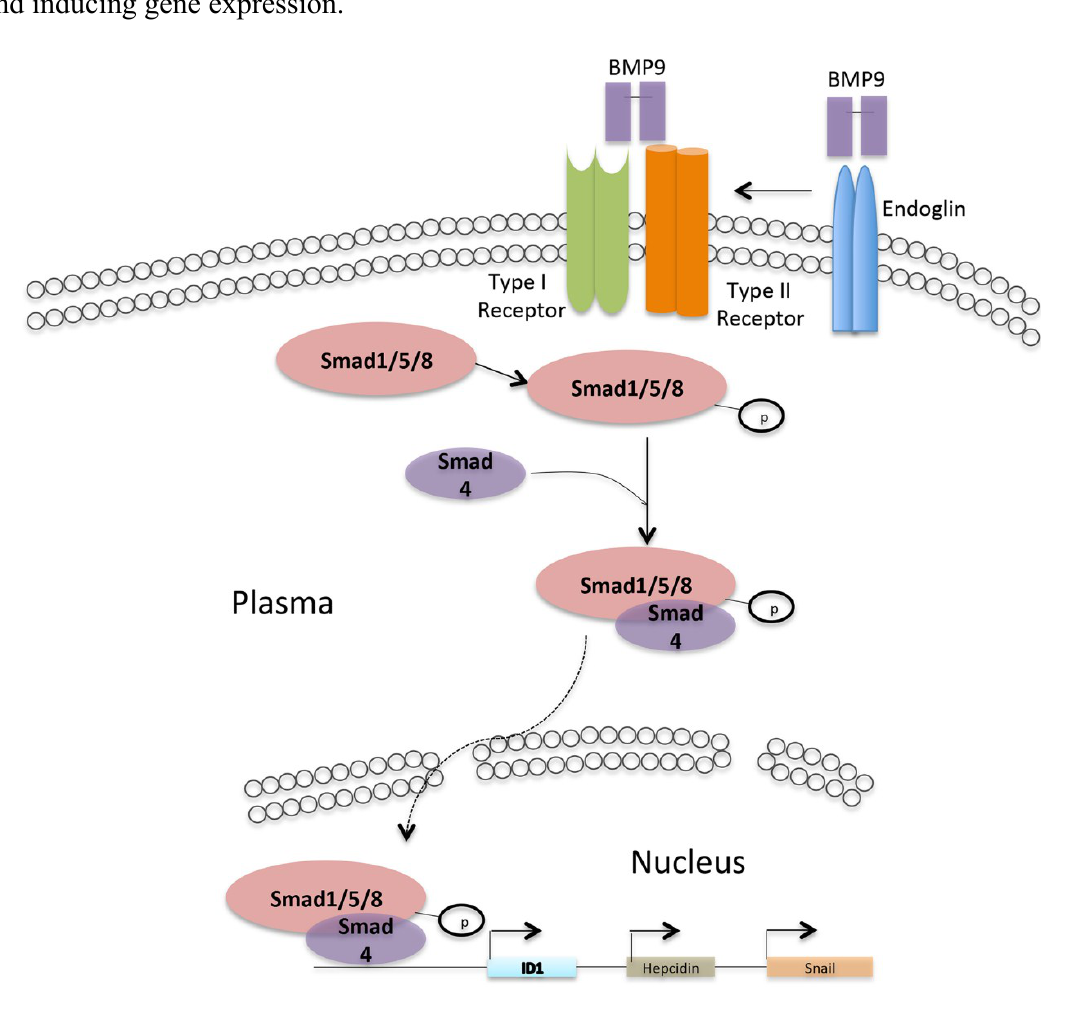
Figure 2. BMP signaling pathway. BMP9 signal transduction in liver cells: BMP9 signal via the type I receptor (ALK1, ALK2) and type II receptor (BMPR2, ActRII) in liver cells. The co-receptor endoglin can modulate signaling via the type II and type I receptors. Activated receptors bind to Smad1, Smad5, Smad8 and phosphorylate the proteins, the activate complex translocates to the nucleus, and bind to Smad-responsive element in the target gene and inducing gene